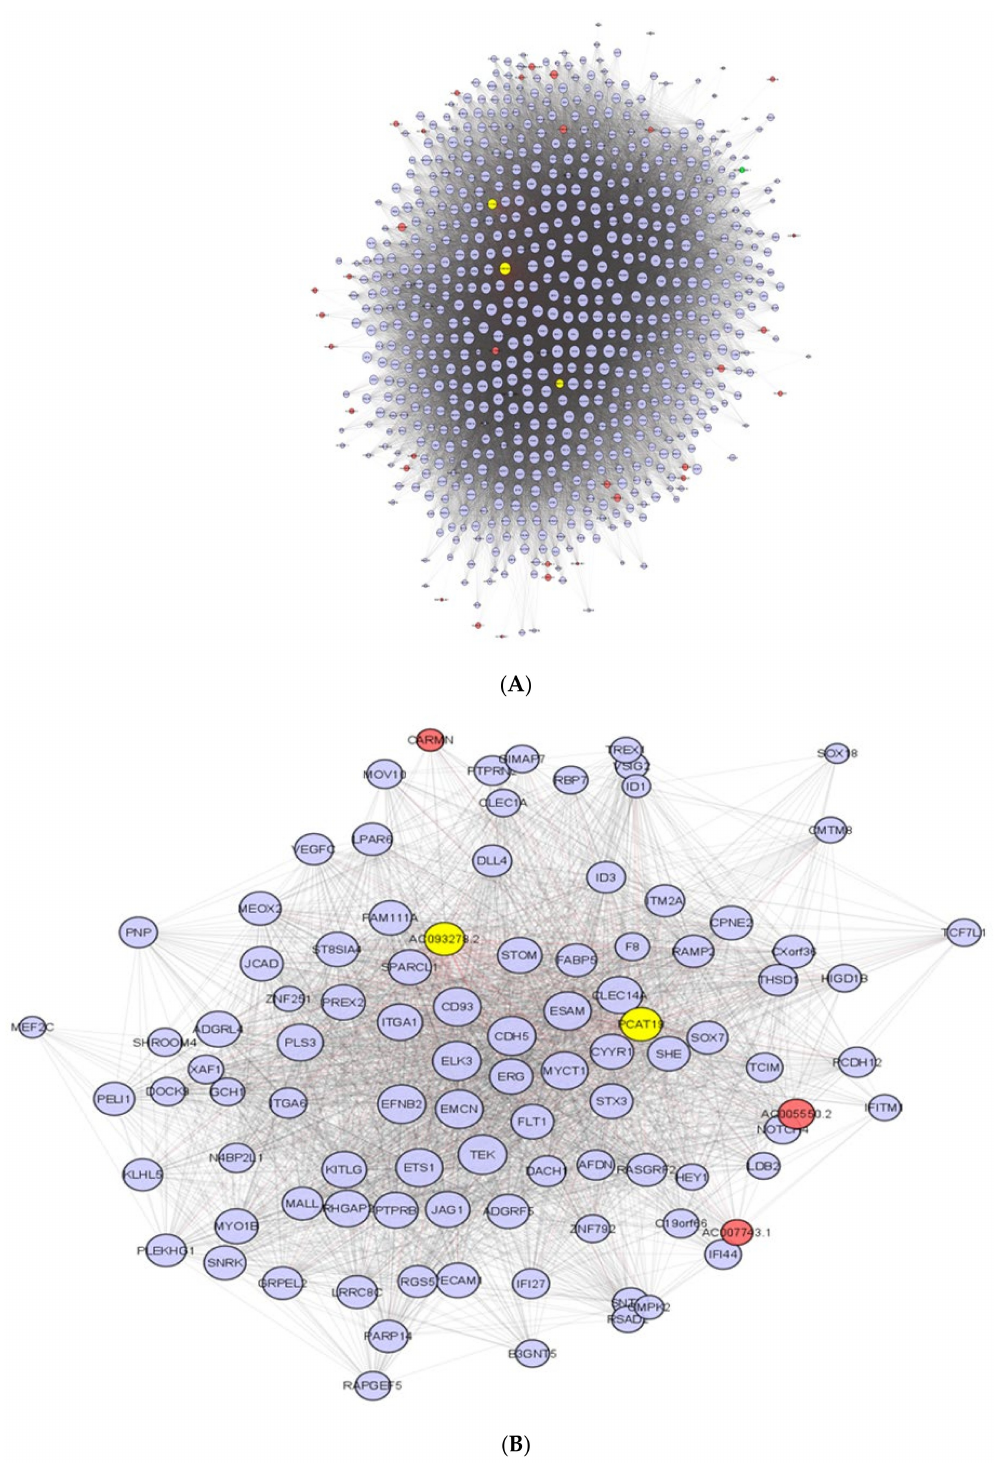
Figure 4. Co-expression network between lncRNAs and mRNAs in each module. ( A ) Module 1 shows genes enriched in pathways associated with cell death, apoptosis, and necrosis. ( B ) Module 2 shows genes predicted to activate pathways involved in angiogenesis and vascular development in the cardiovascular system and proliferation of white blood cells and immune cells. Yellow nodes represent lncRNAs with the highest module membership and putative hub genes; Red nodes represent (annotated) lncRNAs; Green node (Module 1) represents the ischemia associated novel lncRNA; Purple nodes represent